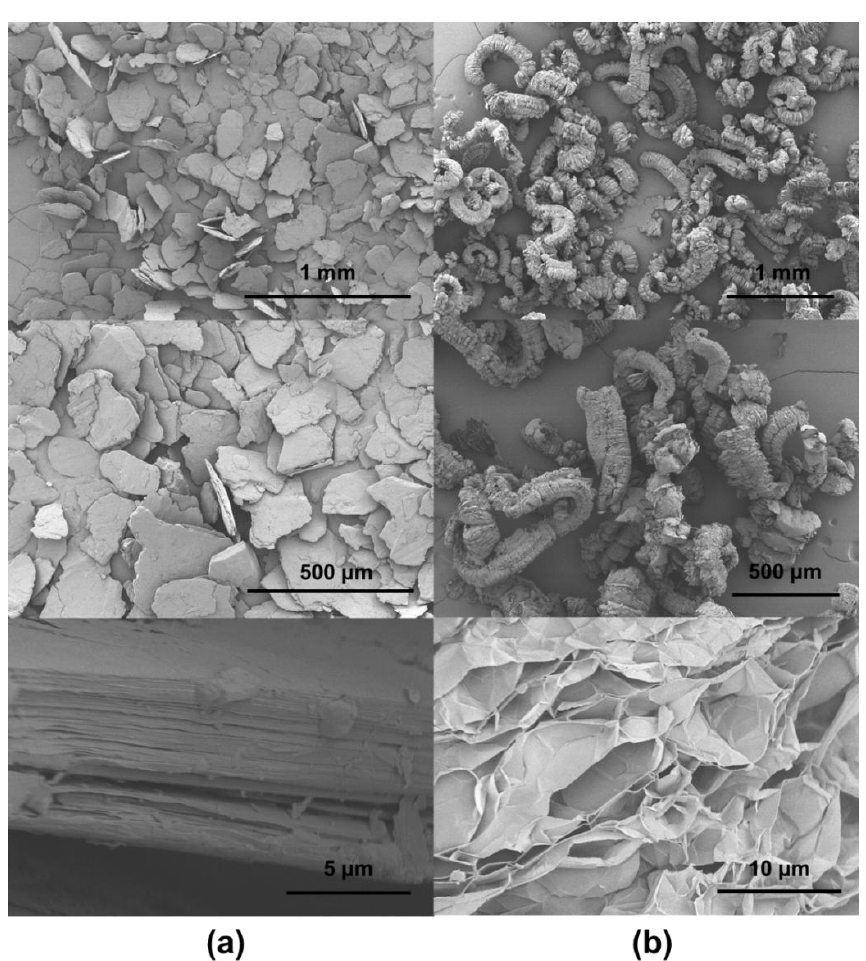
Figure 1. Scanning electron microscopy (SEM) images of expandable graphite: ( a ) before expansion; ( b ) after expansion. Exfoliation of the graphite sheets is clearly visible after thermal expansion.